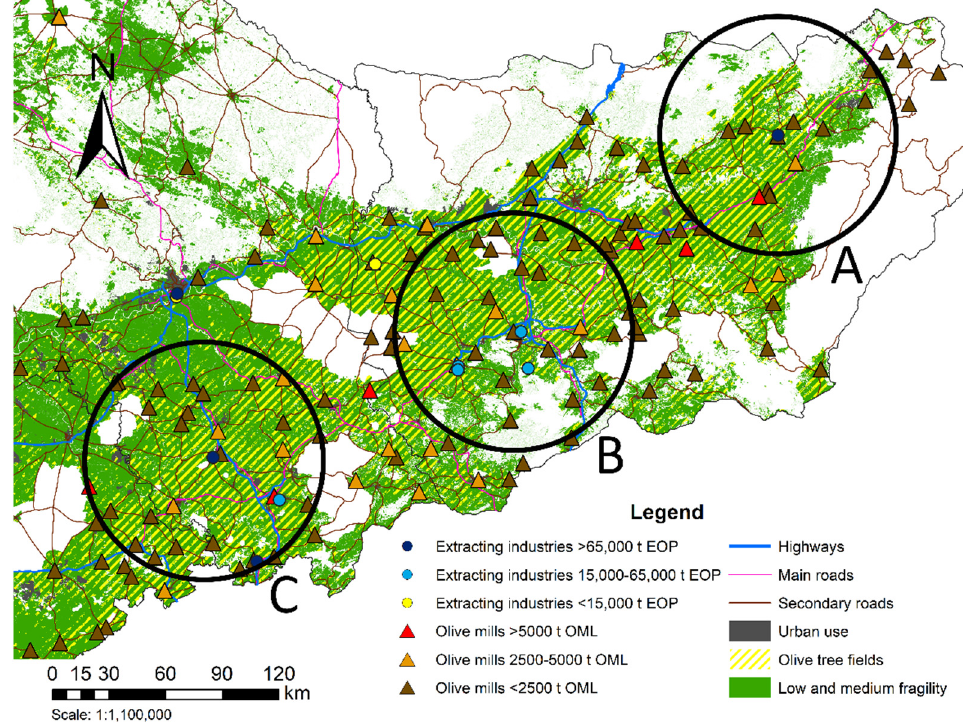
Figure 8. Selected locations for the implementation of olive biorefineries.